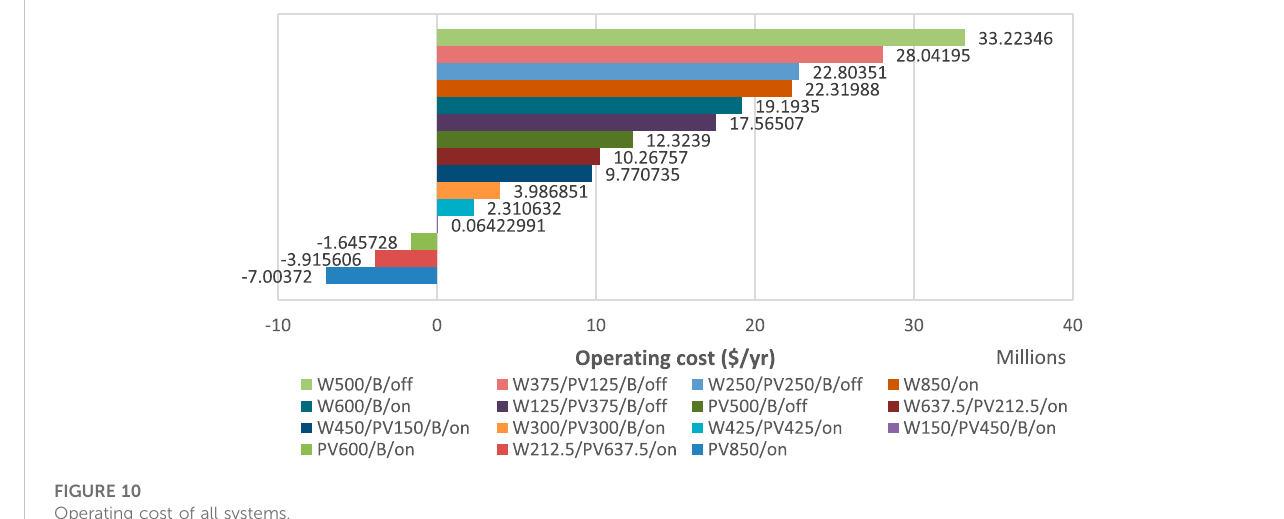
FIGURE 10 Operating cost of all systems.